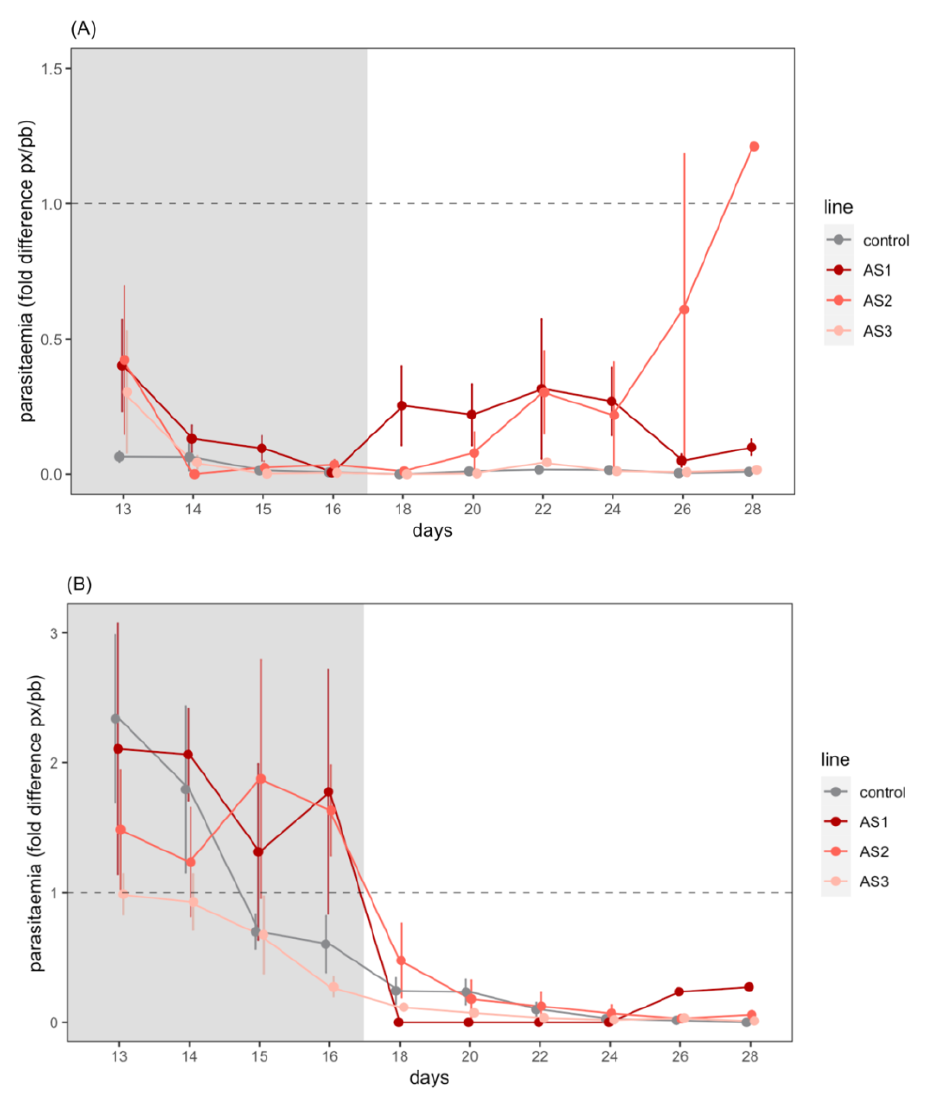
Figure 2: Experiment 1. Parasitaemia (mean ± s.e) in artesunate-treated ( A ) and untreated ( B ) birds. Shaded area corresponds to the 4-day treatment period (measurements taken 24h after each injection). Untreated birds were sham injected with the artesunate solvent. Dashed line indicates the baseline parasitaemia on the day immediately before the first injection (day 12). Bars above/below the dashed line indicate an increase/decrease in parasitaemia with respect to day